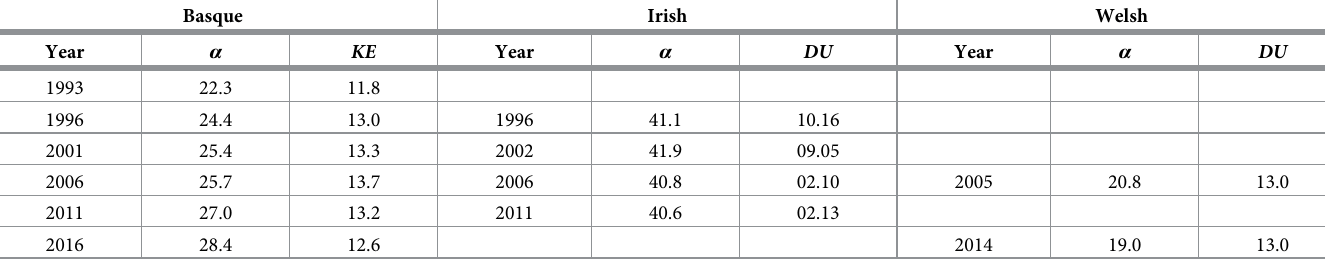
These percentages were not always measured in the same year; and surveys were executed over longer periods. The indicated year refers to the